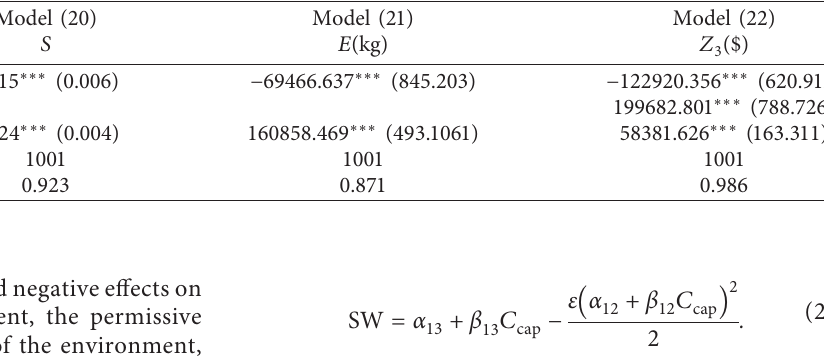
Table 6: Regression results under carbon cap-and-trade